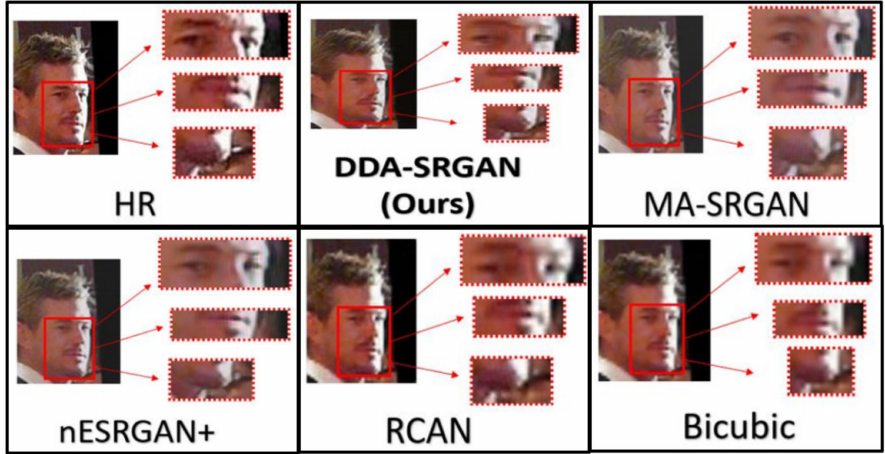
Figure 19. Visual comparison of the super-resolved image of “064049” from CelebA